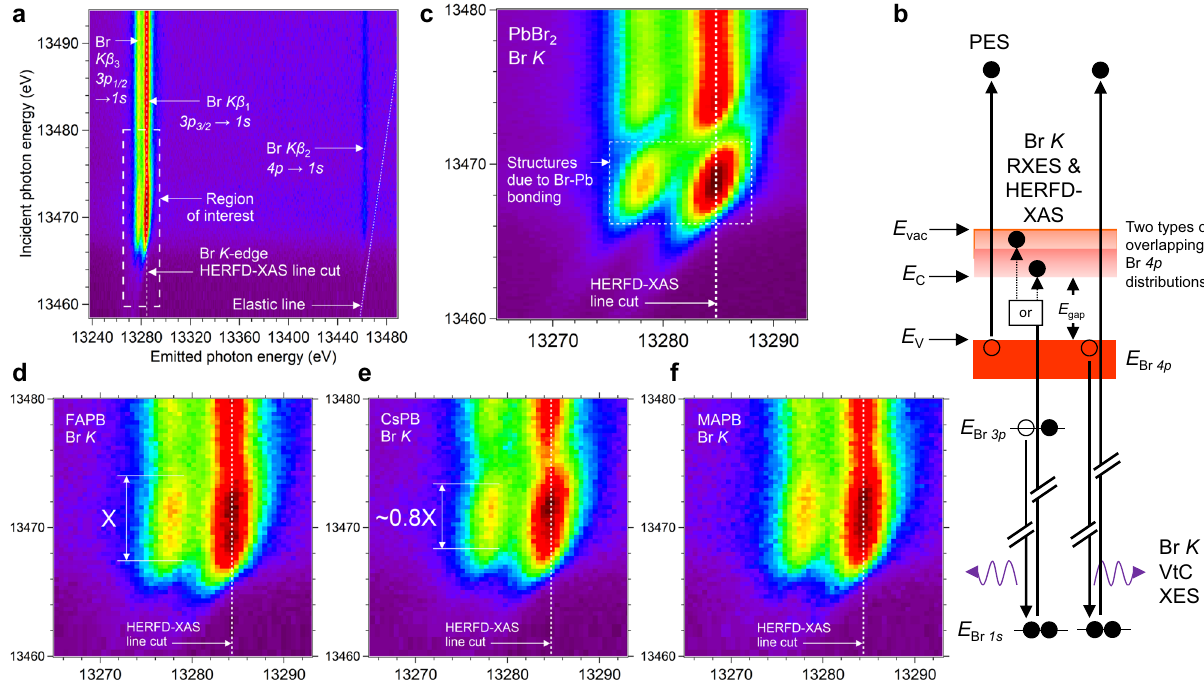
Fig. 1 Bromine K -edge resonant XES full map and region of interest. The High Energy Resolution Fluorescence Detected X-ray Absorption Spectroscopy (HERFD-XAS) line cuts are visualized as dashed vertical white lines in all maps. a Representative Br K full map, recorded from single crystal MAPB. The map shows two core-to-core transitions ( K β 1,3 ) and the valence-to-core transition (VtC, K β 2 ), on- and off-resonance. The elastic line is marked with a guide for the eye. b Energy level diagram depicting the core hole decay processes measured in the Resonant X-ray Emission Spectroscopy (RXES) map, along with the valence photoemission fi nal state for comparison. The valence and conduction band edges are labeled E V and E C , respectively, E gap denotes the bandgap and E vac denotes the ionization threshold or vacuum level. c – f Regions of interest cut from RXES maps recorded from PbBr 2 , FAPB, CsPB and MAPB. The x- and y-axis labels for the regions of interest are the same as the full map. Relative main-edge widths in d,e are marked with “ X ” and “ 0.8X ”